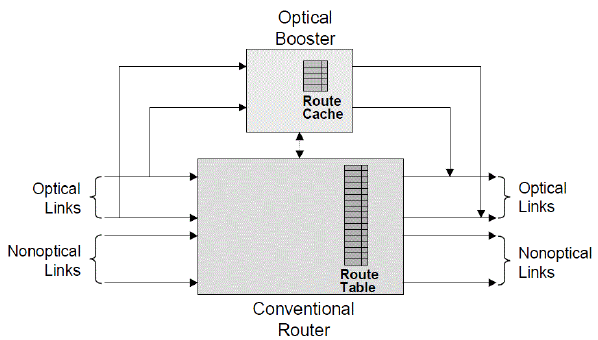
Figure 4. A fast optical booster that runs in parallel with a conventional (slow, electronic) router; packets matching the booster cache are discarded by the conventional router. Nearly all packets are processed on the fast optical path, but a few—whose destination addresses are not cached—must be forwarded on the slow electronic path.